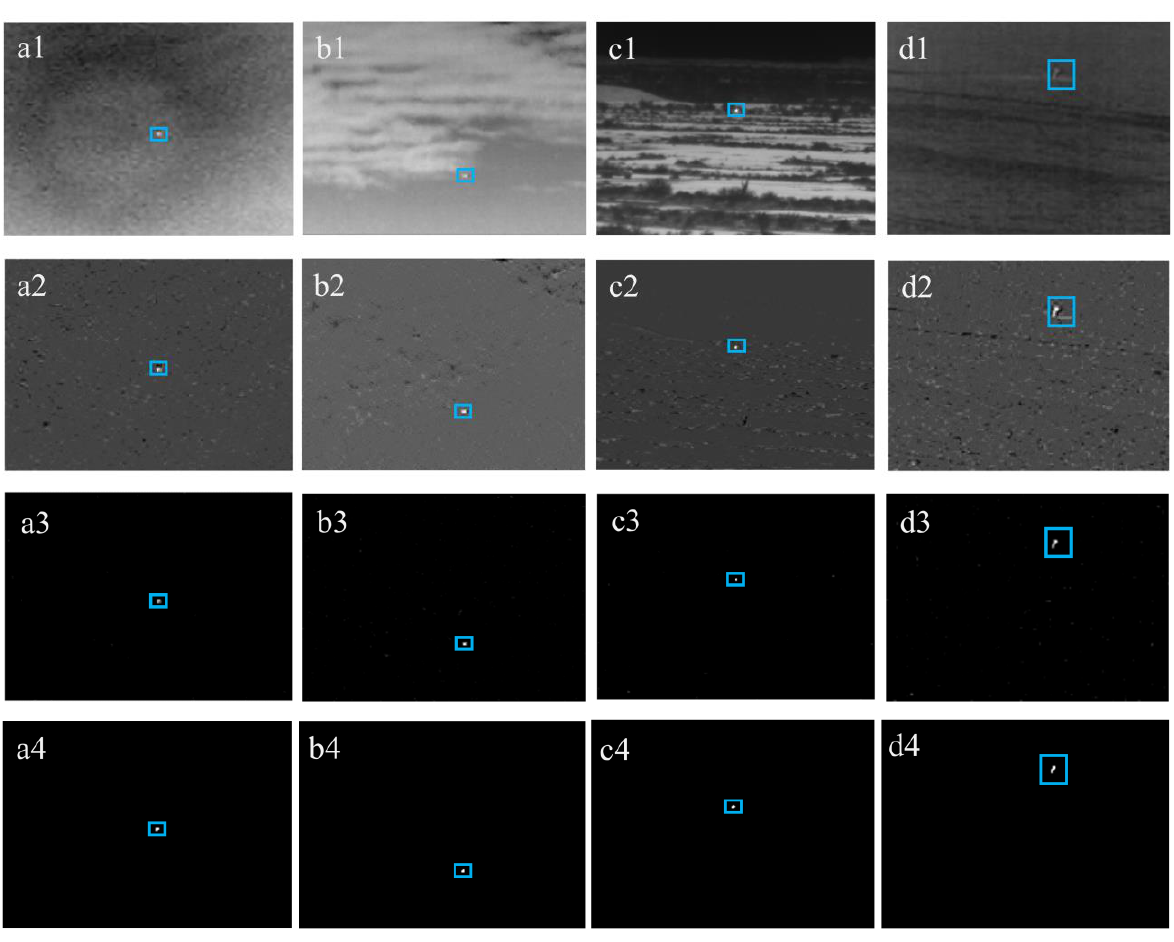
Figure 7. The simulation results at each stage of four typical backgrounds: ( a1 ) sky, ( b1 ) cloud, ( c1 ) land, and ( d1 ) sea; ( a2 – d2 ) show low-rank-matrix image after image decomposition; ( a3 – d3 ) dis- plays the images after the morphological filtering stage; ( a4 – d4 ) show final results.